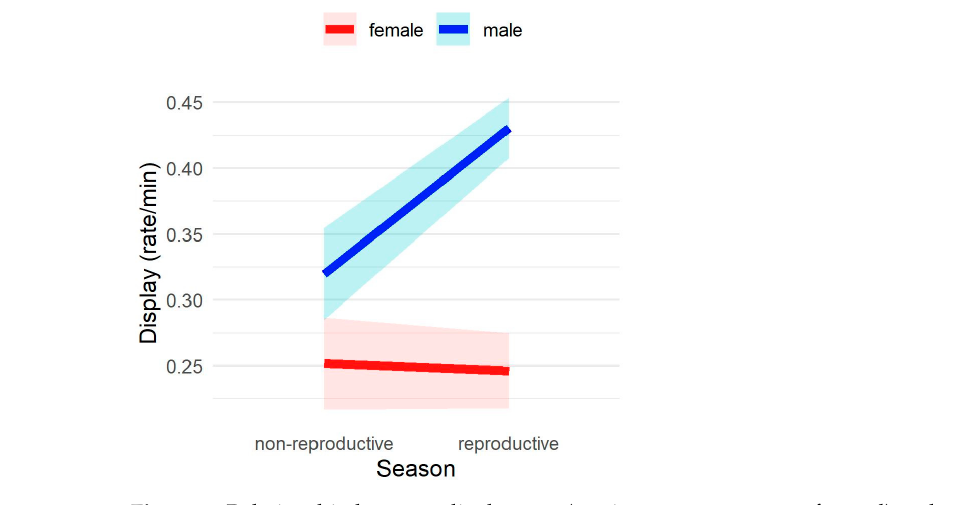
Figure 7. Relationship between display rate (arcsine square root transformed) and season (reproduc- tive vs. non-reproductive) in males and females of Anolis homolechis . Colored ribbons represent 95% confidence intervals.